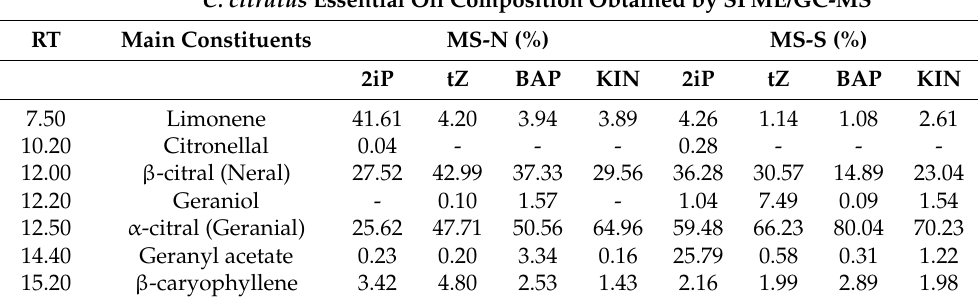
Table 2. Chemical composition of the main volatile oils obtained from lyophilized (freeze-dried) leaves of established plants in pots. RT = retention time; (%) = maximum